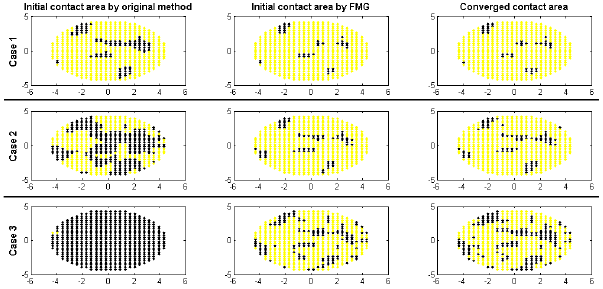
Figure 11. Rough contact: contact area on a 32 × 32 grid for Cases 1, 2 and 3. The first column: the initial contact area obtained by the original method, selecting all the elements I with h I ≤ 0; the second column: the initial contact area by the FMG scheme; the last column: the converged contact